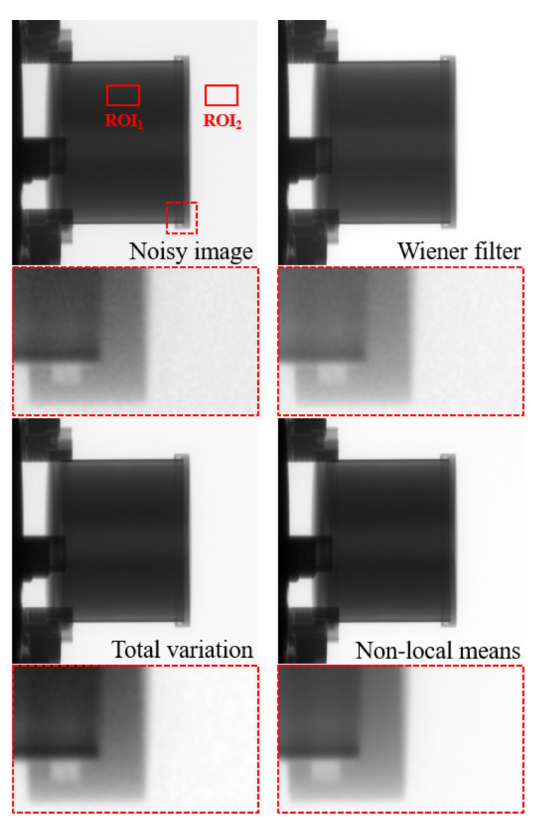
Figure 7. Images of the concrete dummy phantom: noisy, Wiener filter, total variation, and proposed non-local means denoising algorithm, acquired with our established industrial high-energy X-ray imaging system. The contrast-to-noise ratio and coe ffi cient of variation were calculated for the specified regions of interest (ROI 1 and ROI 2 ).